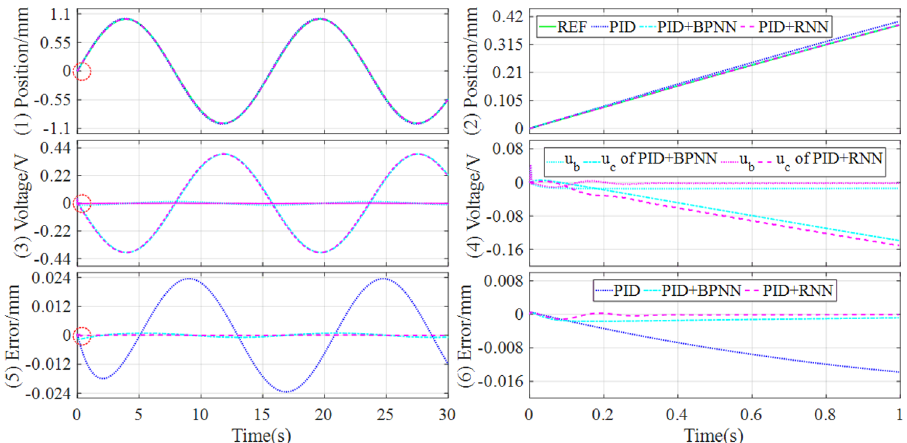
Figure 7. Simulation results of tracking sinusoidal signal under the different controllers.